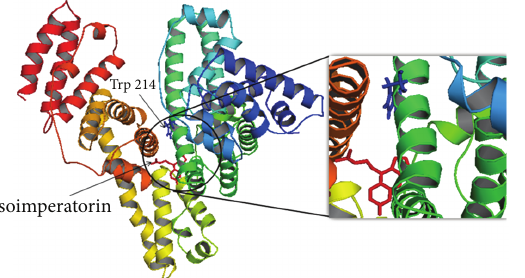
Figure 11: Crystal structure of HSA and the positions of single tryptophan residue (Trp 214) and also the binding site of isoim- peratorin in HSA. Protein backbone is shown in the “cartoon” representation, and isoimperatorinand Trp 214 residue in the site I are shown in the “stick” representation. The isoimperatorin and Trp 214 structures are represented by the red and blue colors. The crystal structure of protein was obtained from Protein Data Bank (1BM0). For interpretation of references to color in this figure legend, the reader is referred to the web version of this paper.